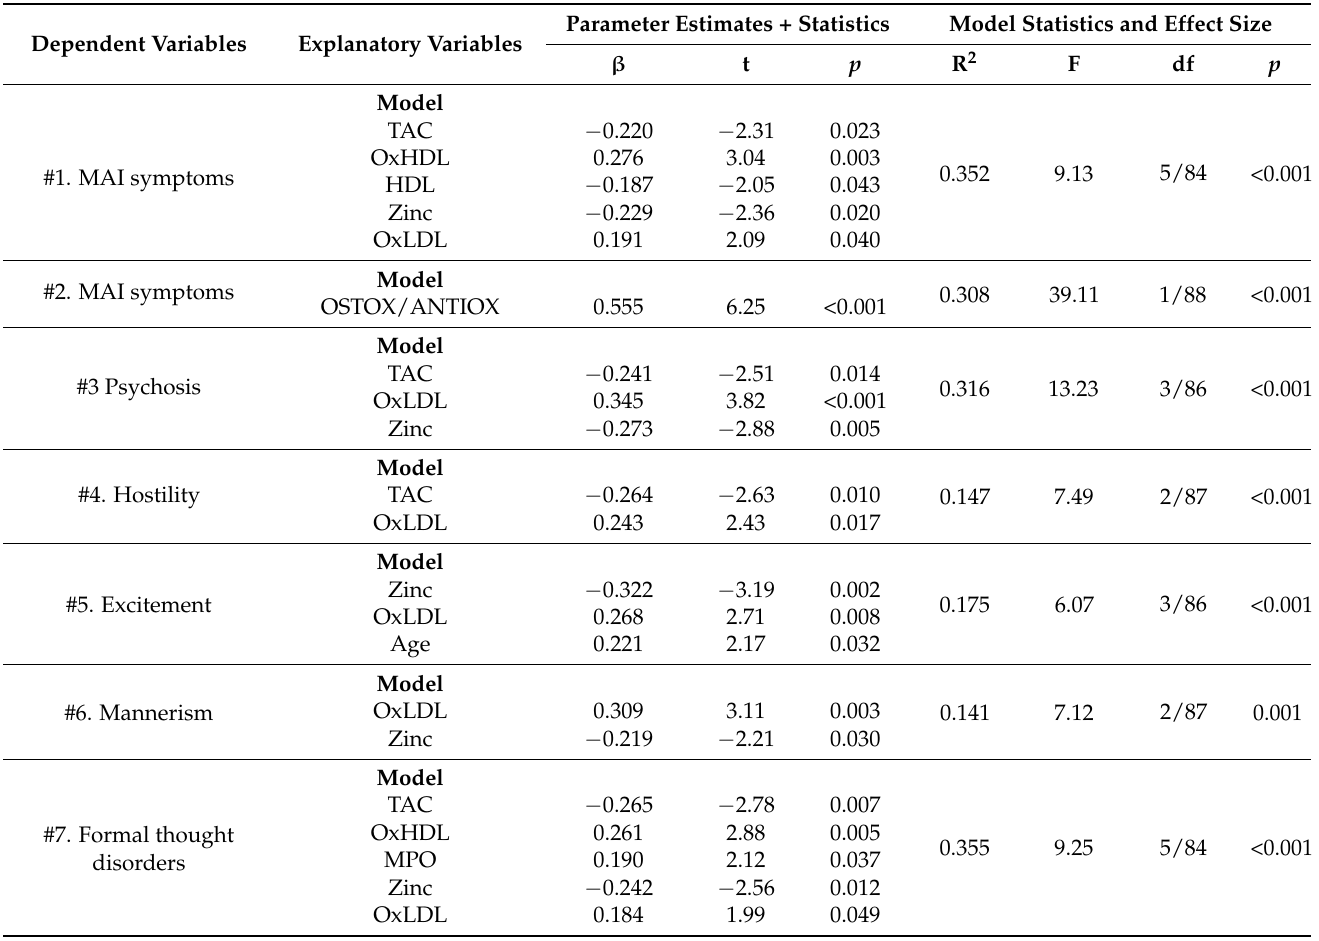
Table 5. The results of multiple regression analyses with the methamphetamine (MA) intoxication symptoms as dependent variables and oxidative stress biomarkers as explanatory